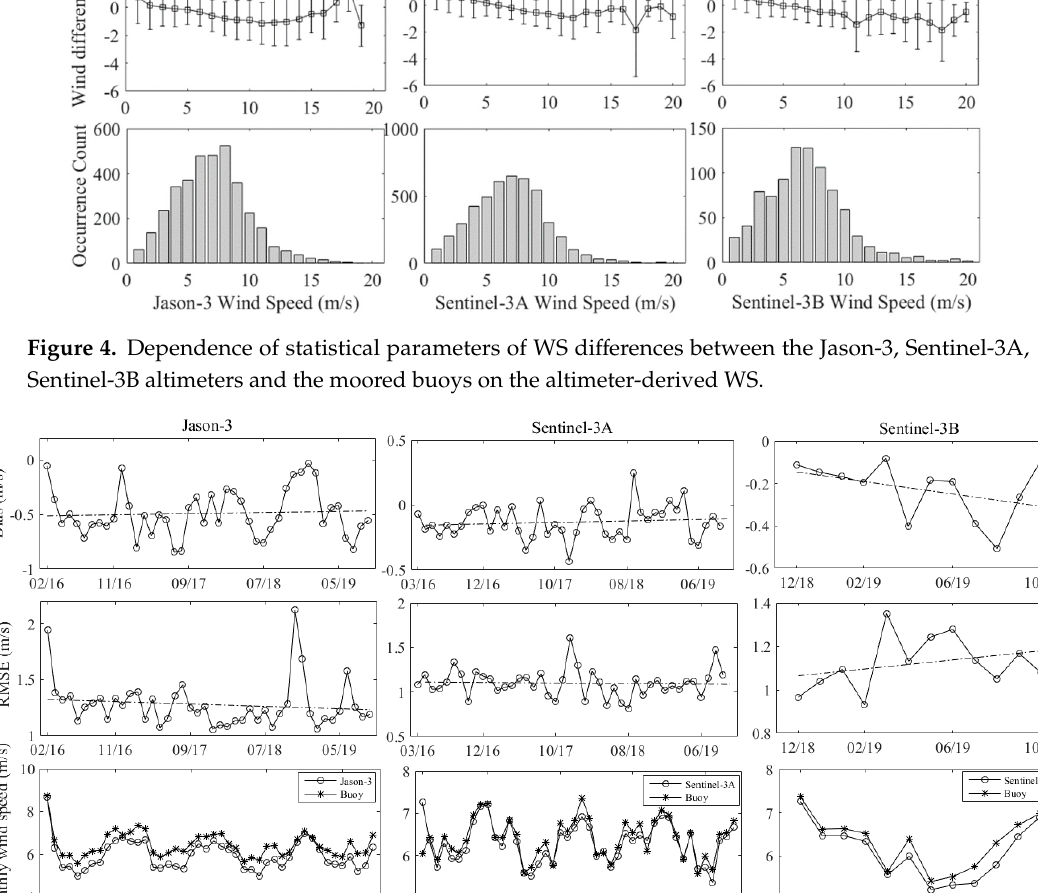
Figure 5. Monthly RMSEs and biases of WS differences between the Sentinel-3A/3B and Jason-3 altimeters and the moored buoys across different months and the average monthly WSs of the collocated data. the dotted straight lines represent the fitting trends.